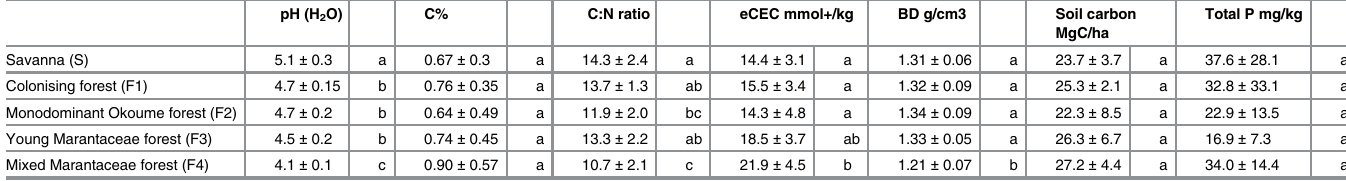
Table 1. Soil characteristics, 0-30cm depth, per forest type, including soil pH, Carbon %, C:N ratio, effective cation exchange capacity (eCEC), Bulk Density (BD), soil carbon and total Phosphorus.